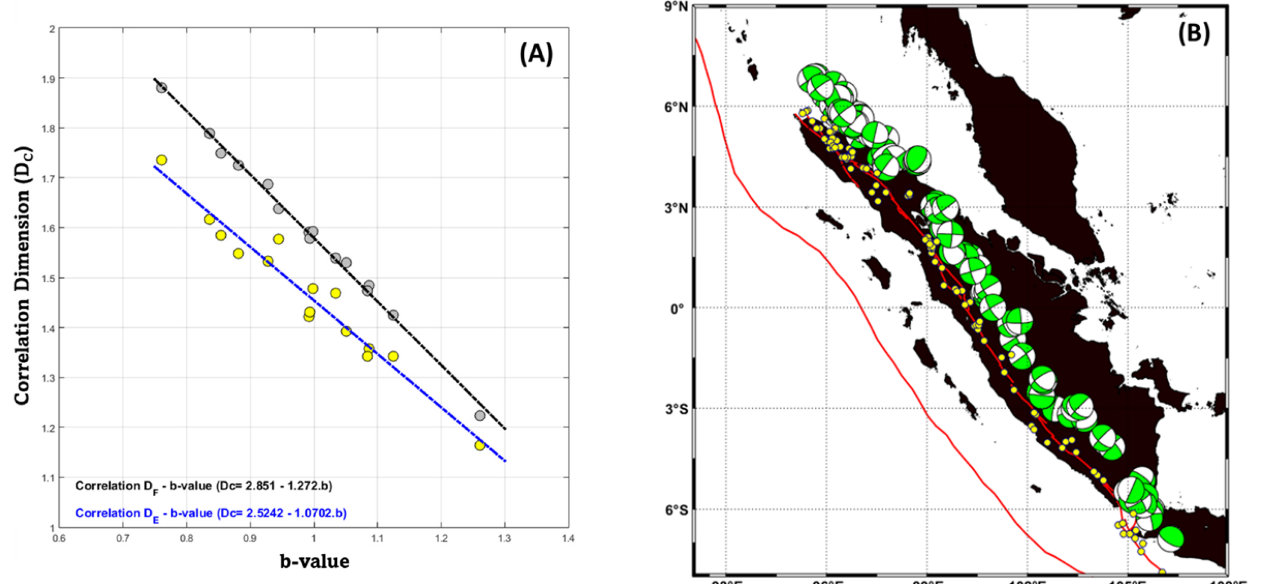
Figure 3. The cross-plot D F , D E , and the mean b-values are estimated based on the 15 zones ( A ). The focal mechanism plot is based on the GCMT catalog of shallow earthquake data for earthquakes at depths less than or equal to 50 km with a magnitude larger than or equal to 4.7 in the earthquake period between January 1976 to December 2020 [65,66] ( B ).